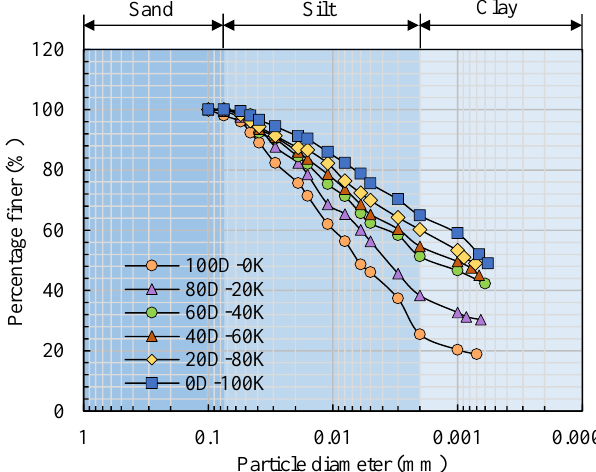
Figure 12. Particle size distribution of DS with different diatom content.